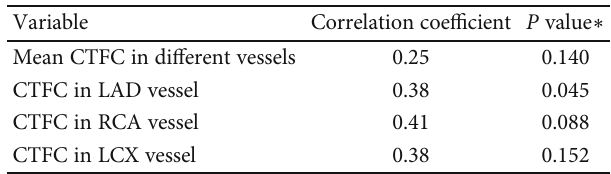
Table 3: Comparison of the mean serum concentration of ADMA in patient groups with di ff erent BMI